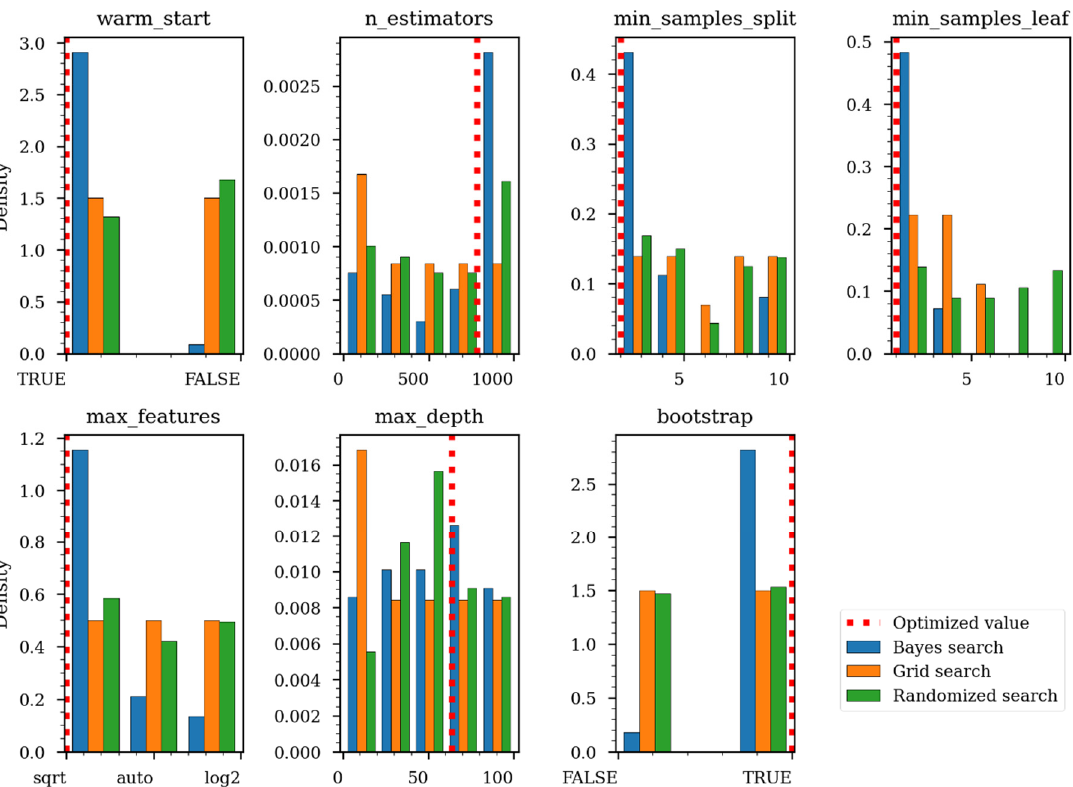
Figure 7. Probabilistic density histograms of sampled hyperparameter spaces with three algorithms compared with the hyperparameters optimized by the Bayesian search algorithm.